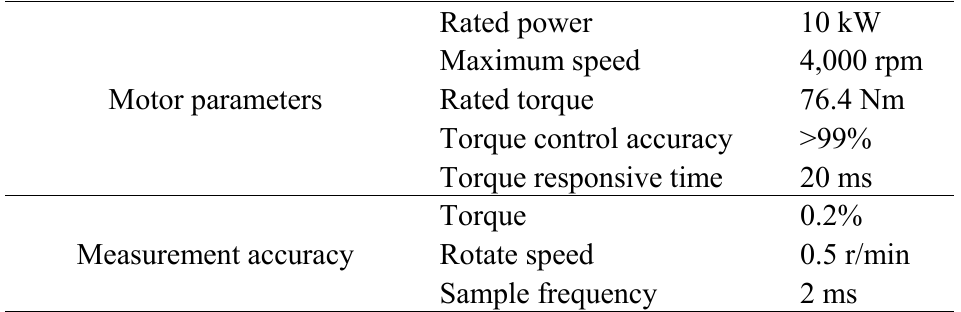
Table 7. Parameters of the bench motor and measurement accuracy of the